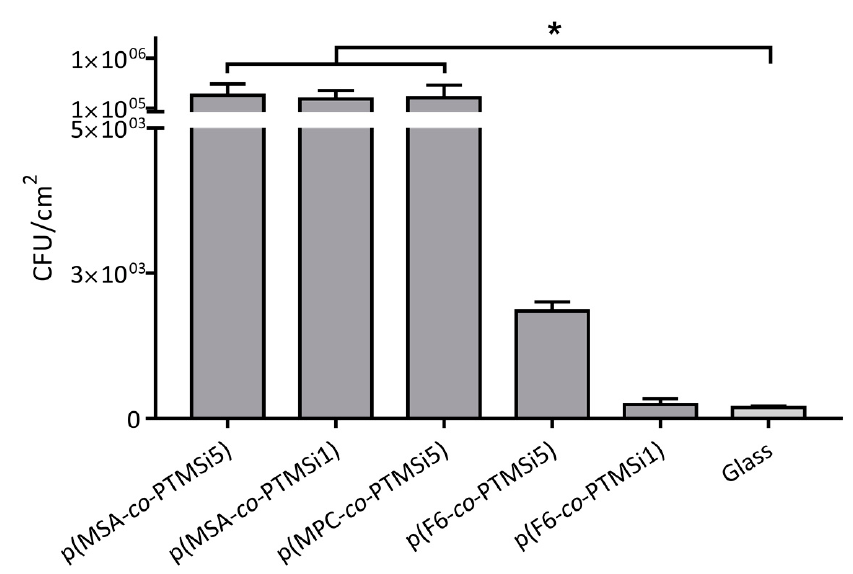
Figure 8. Adhesion of C. albicans to zwitterionic and fluorinated films; * p ≤ 0.05 (first set of experiments).